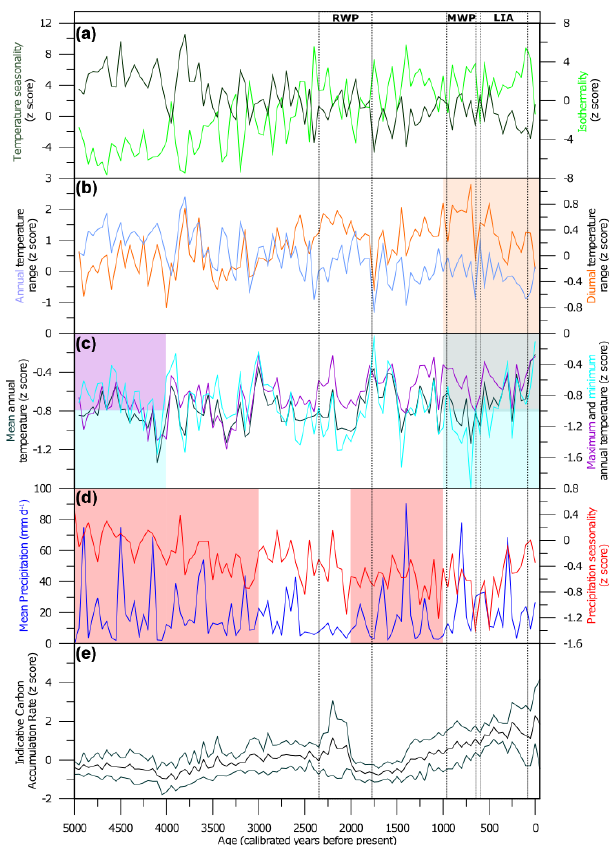
Figure 4. Comparison of the carbon accumulation rate (CAR) com- posite with climatic variables as extracted from our modelling ap- proach. Panels (a) – (d) show the climate variables in this study used for the comparison with the reconstructed CAR for central–eastern Europe shown in panel (e) . Coloured rectangles highlight the 1000- year periods in which a statistically significant correlation between CAR and the variable of that colour are observed (e.g. precipita- tion seasonality and CAR in the period from 1950 to 1000 years BP in panel d ). When two variables significantly correlate with CARs, both colours are indicated using rectangles (e.g. correlation of mean and minimum temperature with CAR in the period from 1000 years BP to present in panel c ). The Roman Warm Period (RWP), the Me- dieval Warm Period (MWP), and the Little Ice Age (LIA) are also indicated using vertical dashed lines.